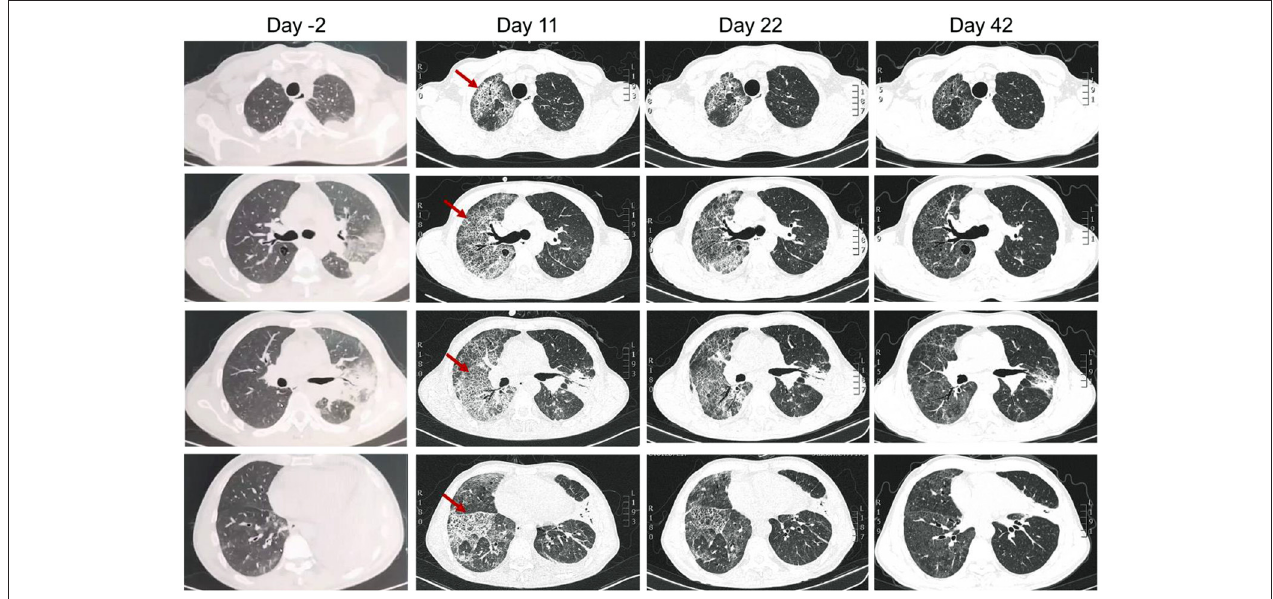
FIGURE 1 | Chest computed tomography of the patient on 2 days before admission (day − 2), and day 11, 22, and 42 (20 days after discharge) after admitted to our hospital. Arrows indicated the right lung developed interstitial infiltrates on day